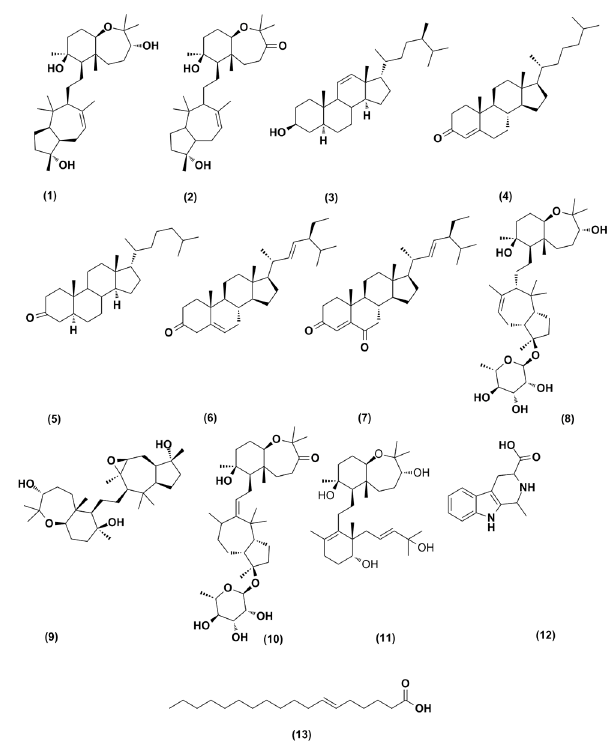
Table 1. Dereplication of the metabolites identified from C. siphonella DCM fraction.